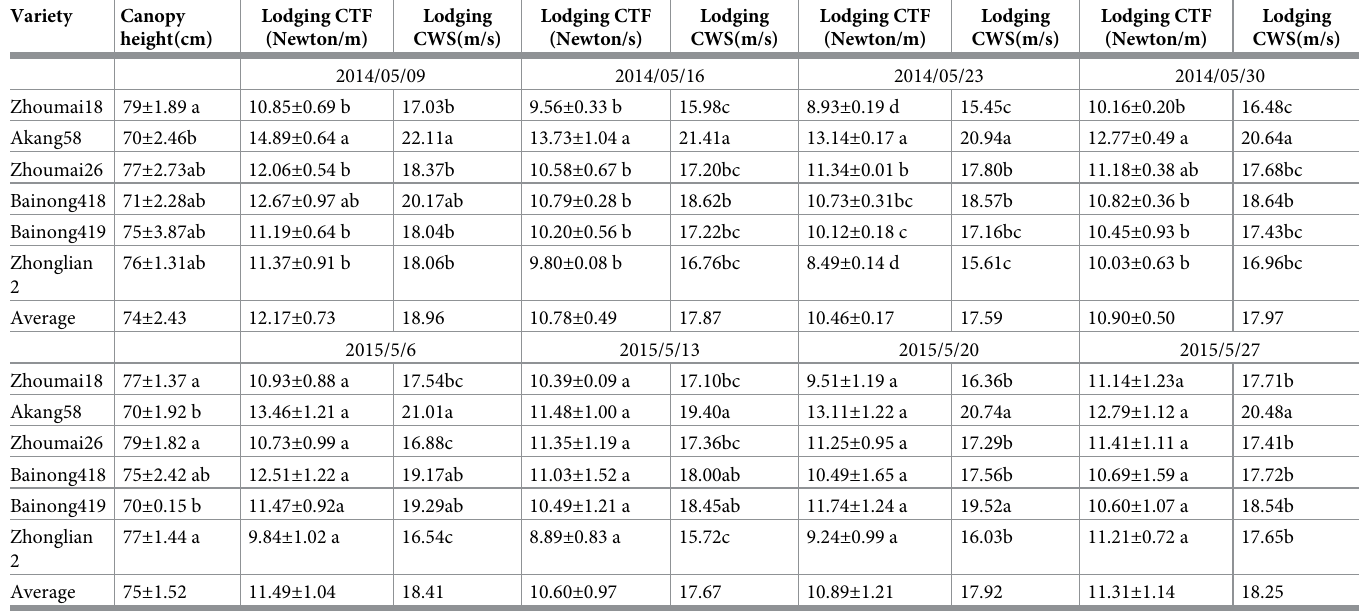
Table 4. The experiment of lodging resistance in the field from 2013 to 2015. Variety Canopy